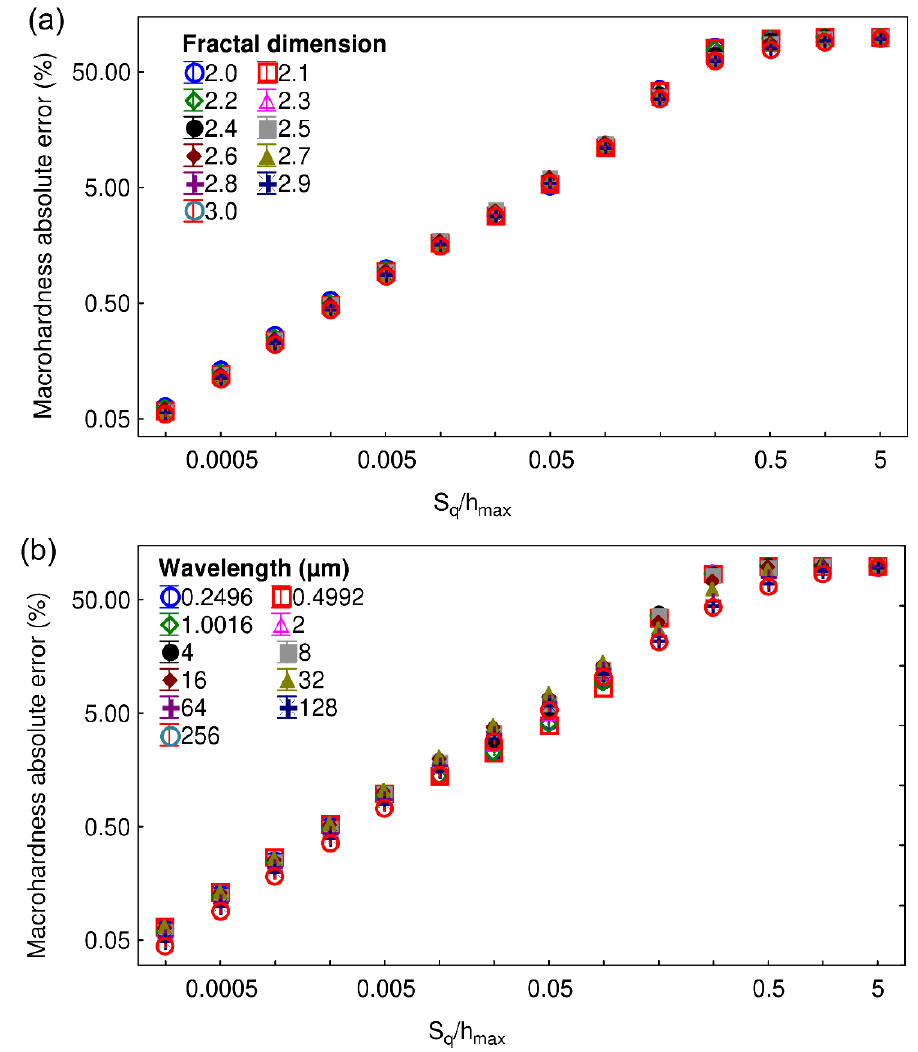
Figure 7. The macrohardness absolute error as a function of S q is computed using ( a ) different fractal dimensions and a fixed wavelength equal to 32 µm and ( b ) different wavelengths with a fractal dimension set to 2.5. The mesh size is 256 × 256.